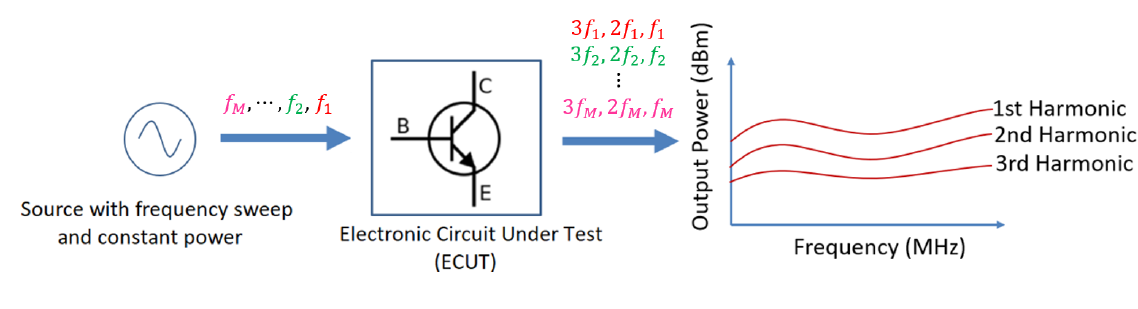
Figure 2. Illustration of the Frequency-Swept Harmonic Radar (FSHR)